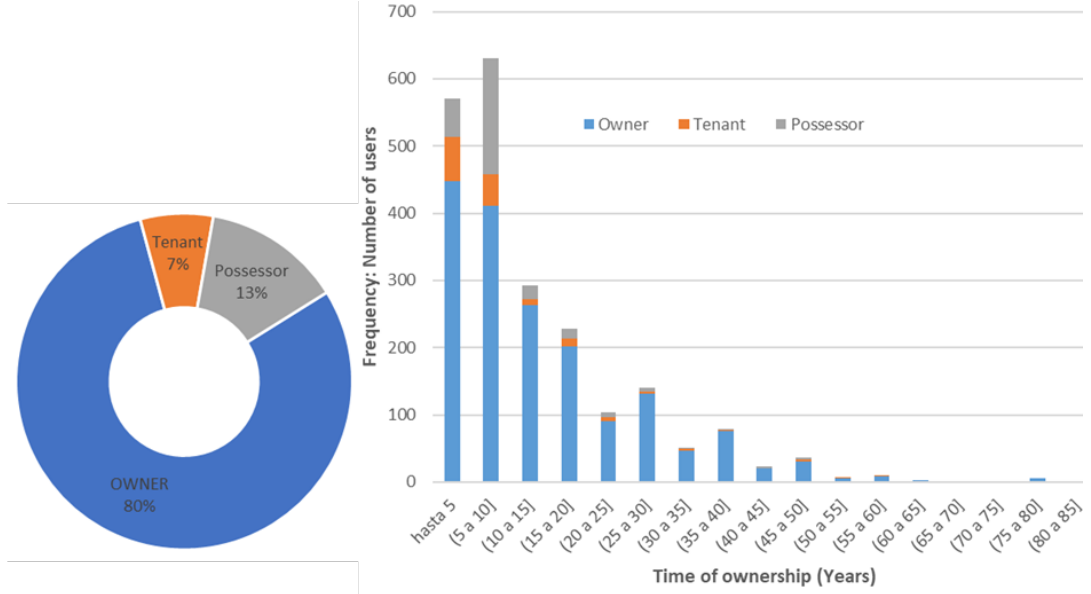
Figure 3. The land tenure condition and time.